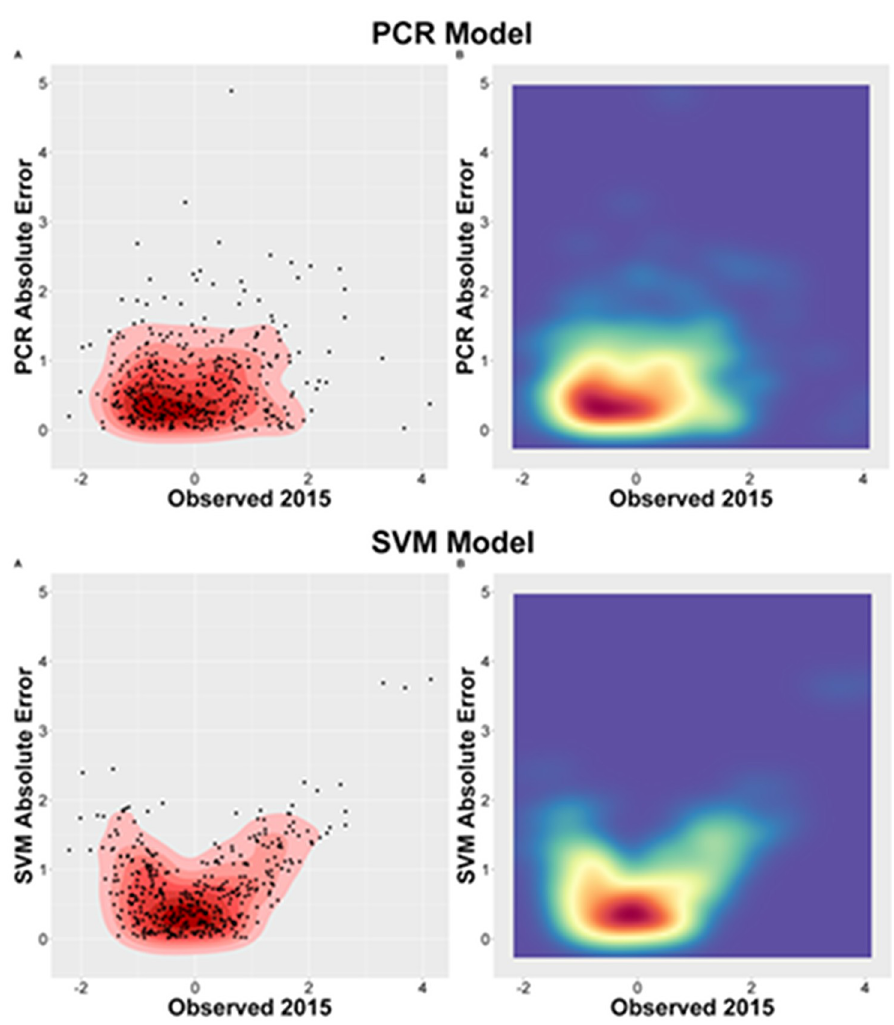
Fig 4. RMSE distribution representation. A—PCR model (2015) B—SVM model (2015).